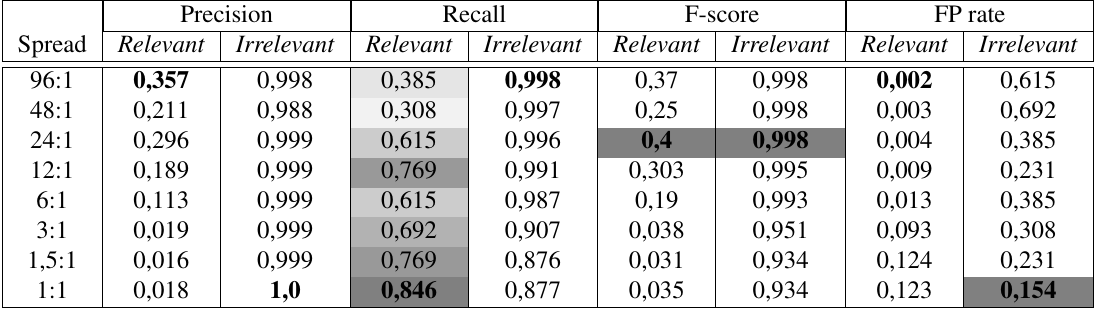
Table 11: Results of BN classifier for category T when applying different spread for random un-